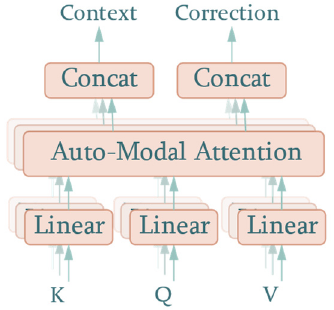
Figure 7. Multi-head attention with multi-output.